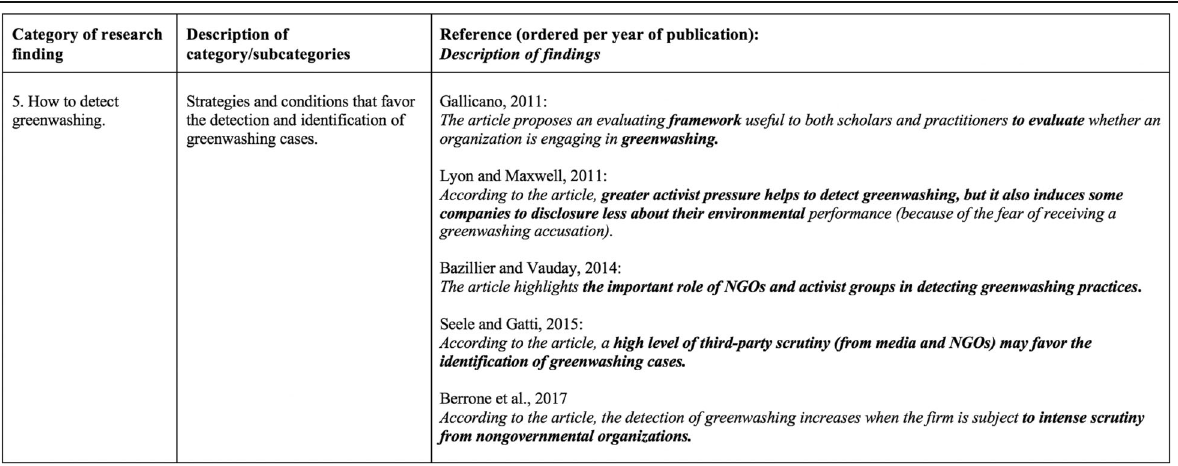
Table 8 Analysis of research findings related to Category